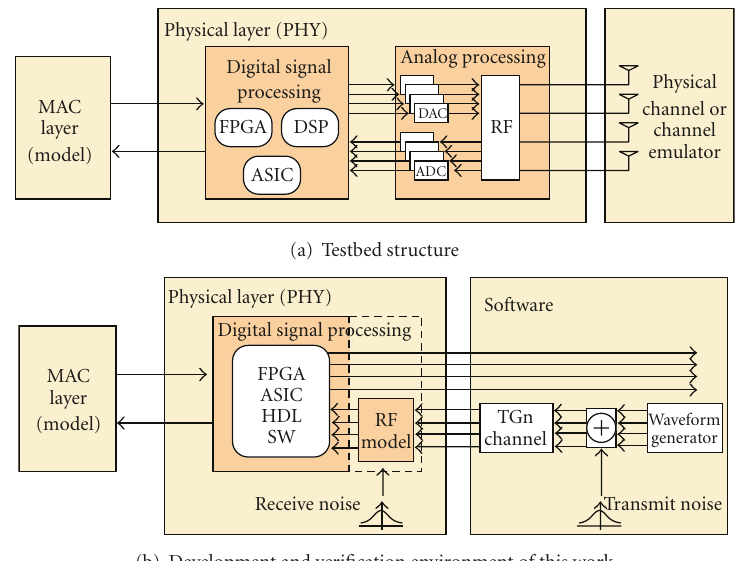
Figure 1: Typical testbed architecture 1(a), and this work’s approach 1(b) (for a 4 × 4 MIMO setup).